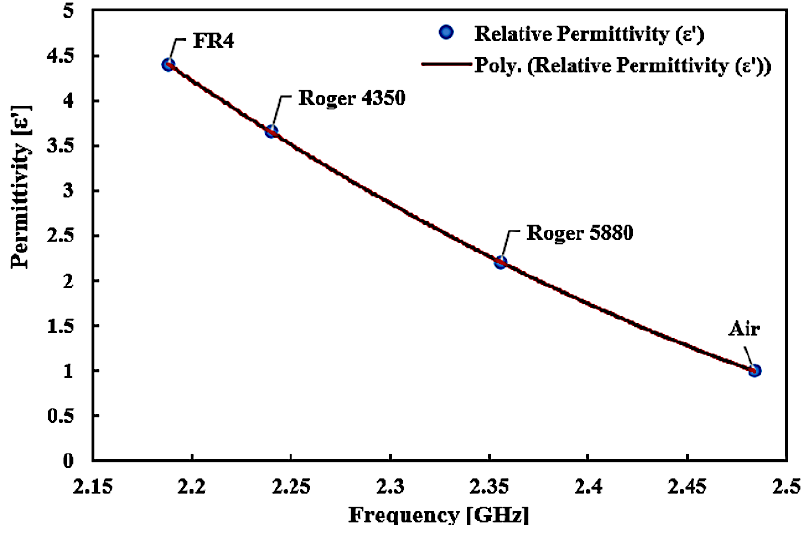
Figure 16. The relationship of known permittivity to extract unknown materials properties of solid SUTs. Through the data collected from the experiment, the resonance frequency is pushed down as the value of the dielectric constant of the loaded samples is elevated, because of the higher capacitance value impact at the split distance. In relation to Equation (1), the higher the capacitance, the lower the resonance frequency. As resonance frequency shifts may be seen as useful knowledge relevant to the permittivity of the loaded sample, the description of the interaction between frequency, , and permittivity, ε , of the sample is designed through the corresponding information provided in Figure 17, utilizing the curve-fitting technique. The term to describe the connection between permittivity and res- onance frequency is as follows: